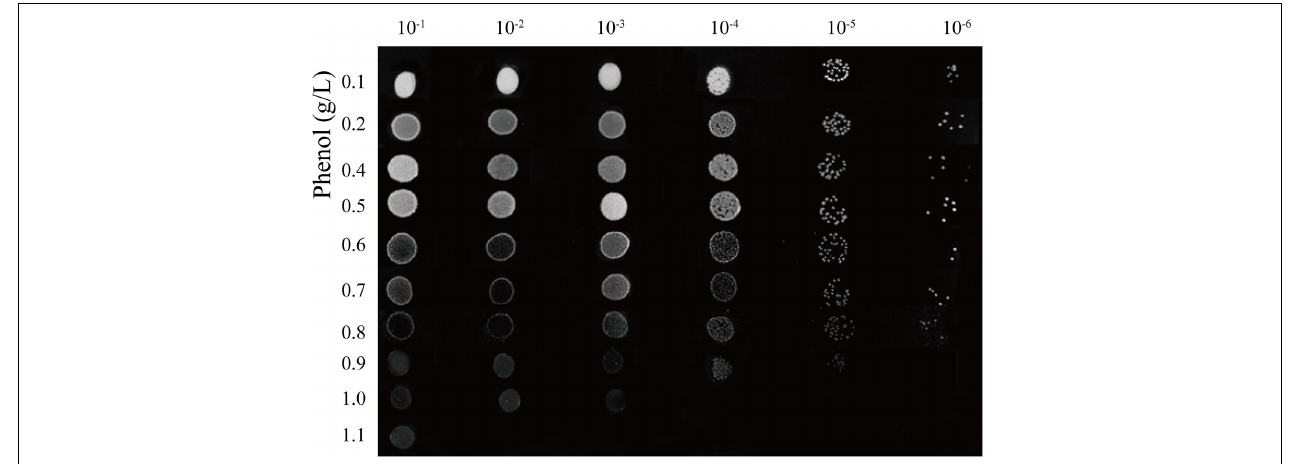
FIGURE 1 | Pot assays of phenol tolerability of A. lwoffii